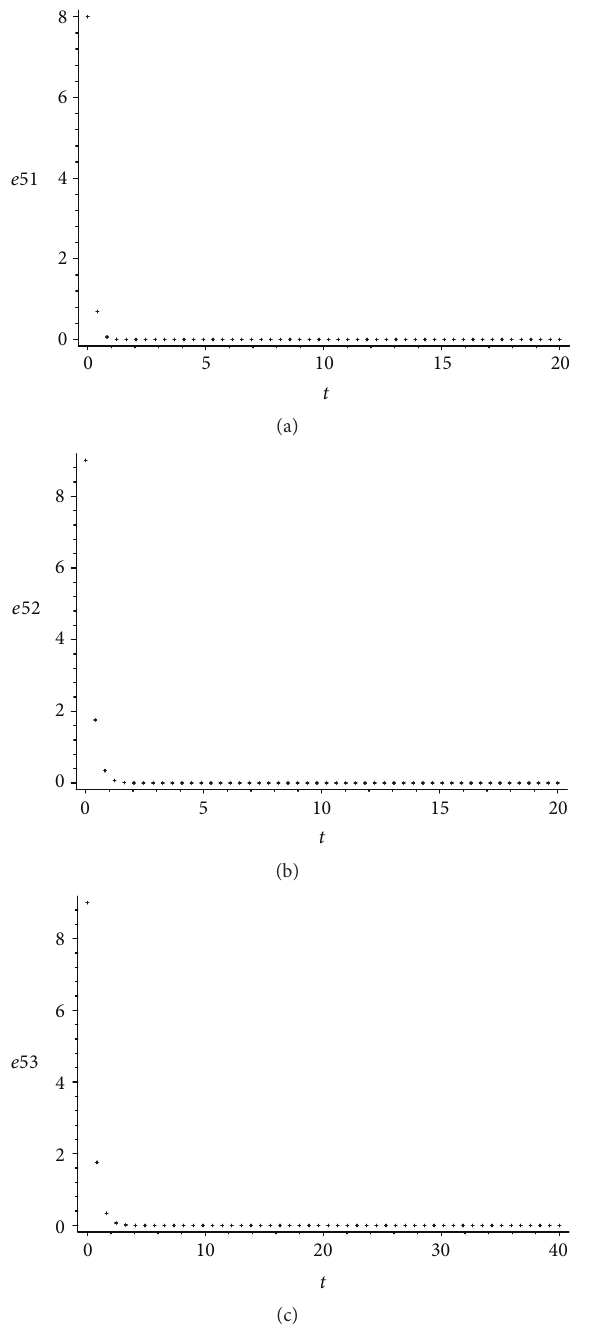
Figure7:Networksynchronizationerrorsbetweennode4andnode 5.